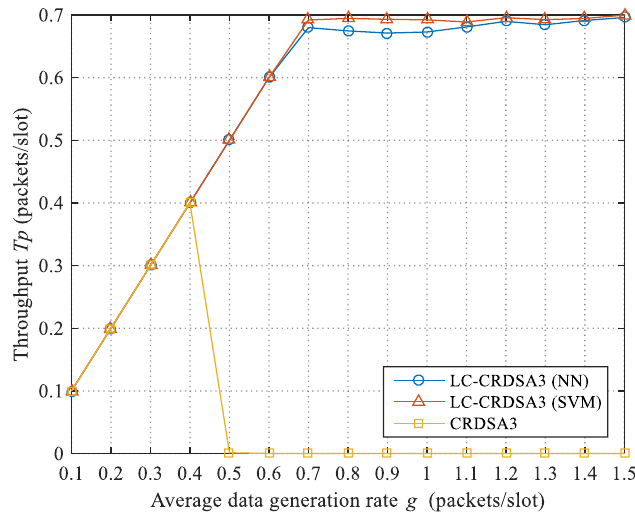
Figure 7. Comparison of throughput between LC-CRDSA3 and CRDSA3.